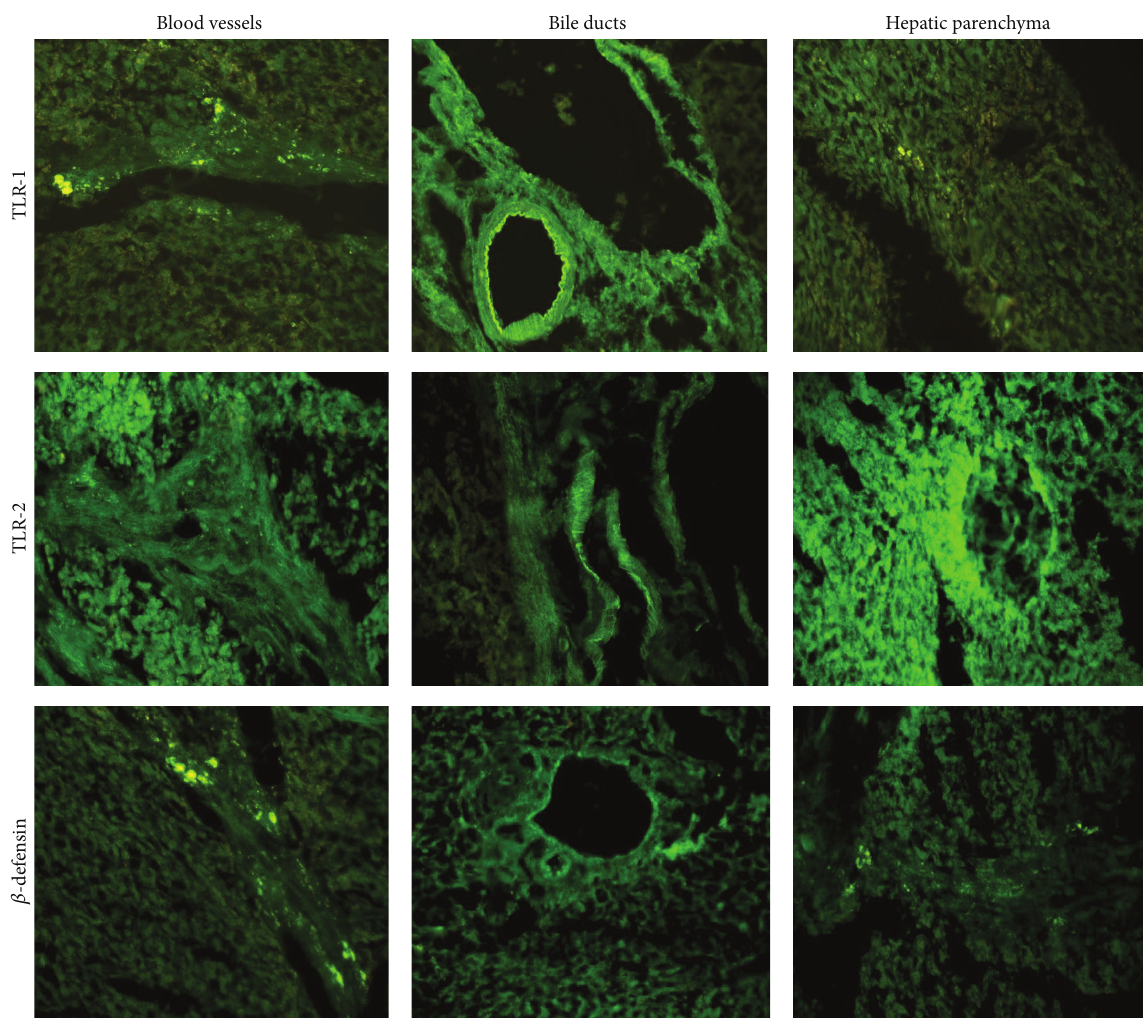
Figure 1: Immunofluorescence of TLR-1 and TLR-2 and 𝛽 -defensin in postcholecystectomy BDI. The antibodies anti-TLR-1 and TLR-2 and 𝛽 -defensin can be positively observed in blood vessels, bile ducts, and hepatic parenchyma of patients who suffered postcholecystectomy BDI. In the immunofluorescence of the epithelium of the bile ducts in liver biopsies, the higher expression of TLR-1 and TLR-2 is attention grabbing, although 𝛽 -defensin is also